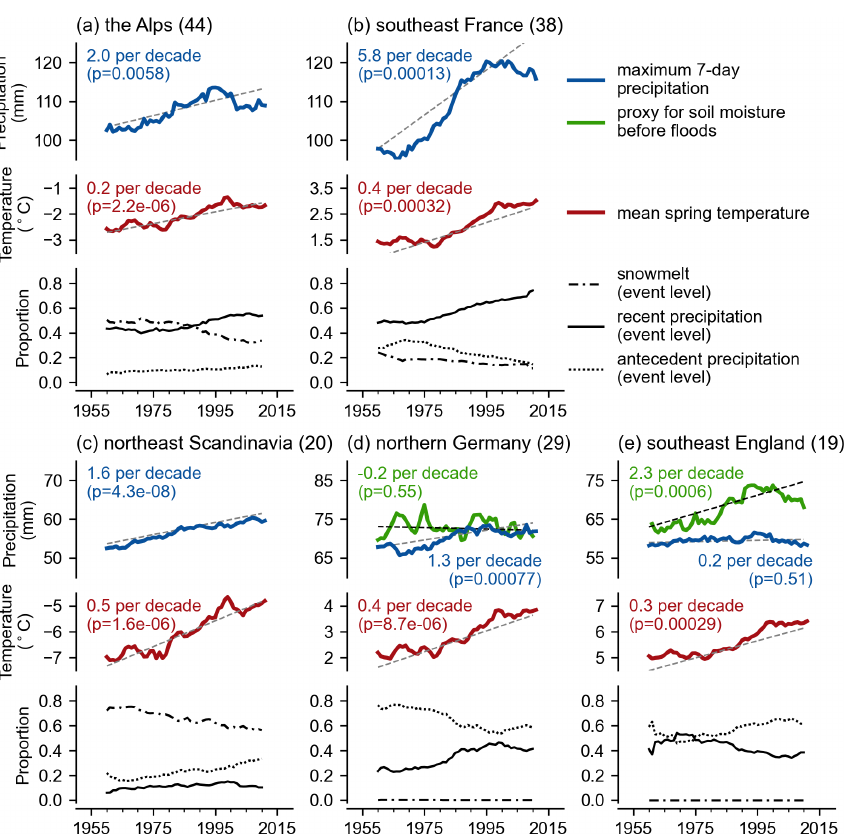
Figure 8. The temporal changes of the event-level mechanisms in relevant catchments within the five selected regions (see Fig. 7c), as well as the changes in average extreme precipitation (represented by annual maximum 7d total precipitation), mean spring temperatures (represented by average temperature between January and April), and antecedent soil moisture conditions prior to flooding (represented by the 30d total precipitation preceding the 7d window of recent precipitation). The numbers in panel titles indicate the number of catchments considered. The proportions were calculated by a 20-year moving window, while precipitation and temperature were smoothed using a 20-year moving average window, with their values at central positions in time windows. The dashed gray lines indicate the slope of relevant trends with their